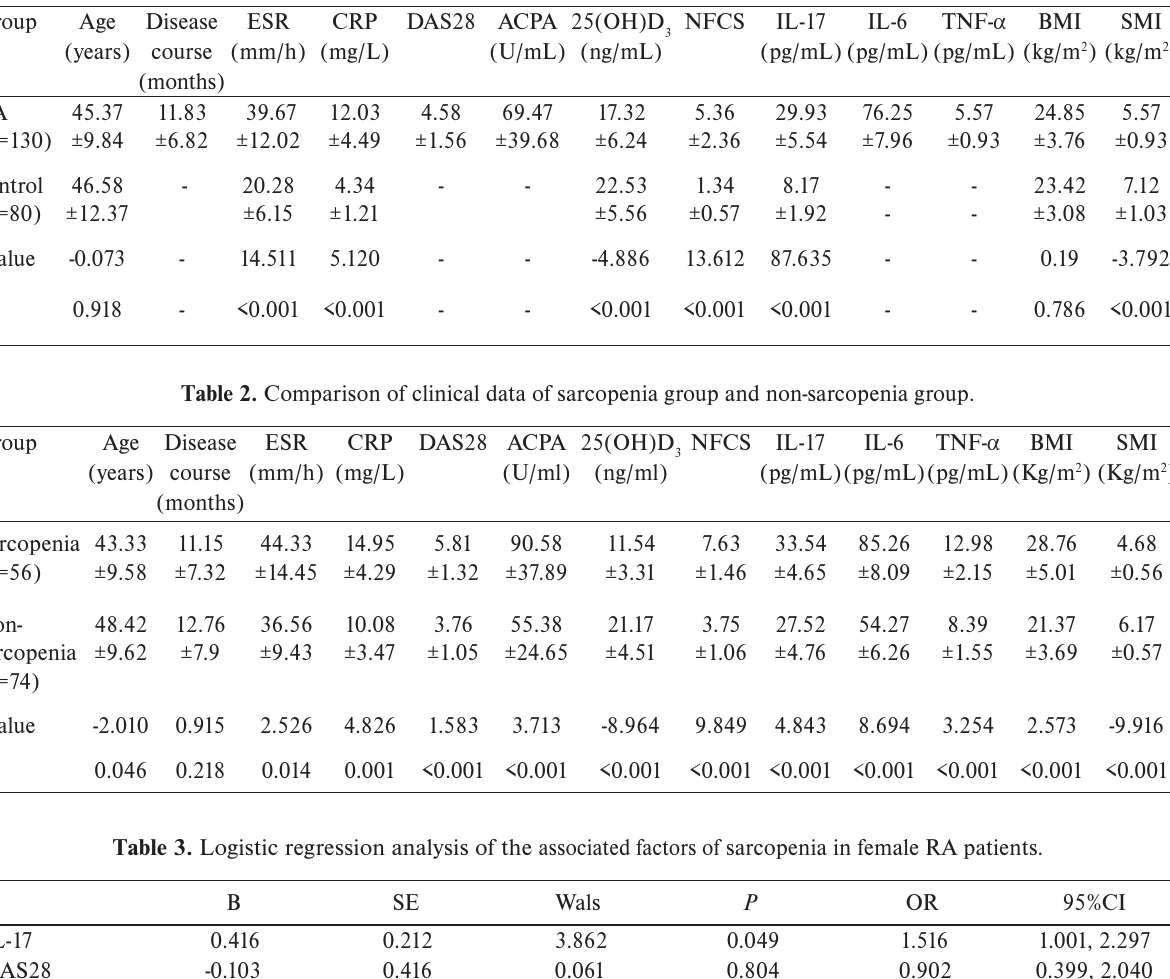
Table 1. Comparison of clinical data of RA and control group.